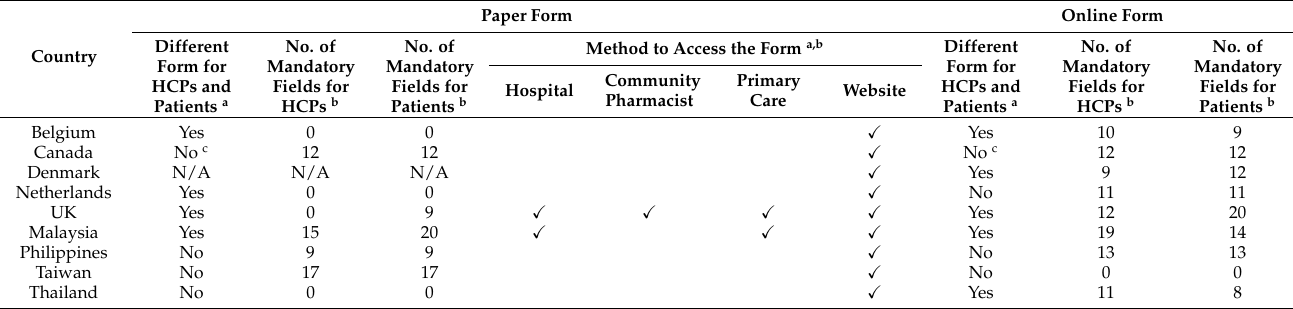
Table 4. Characteristics of patient reporting